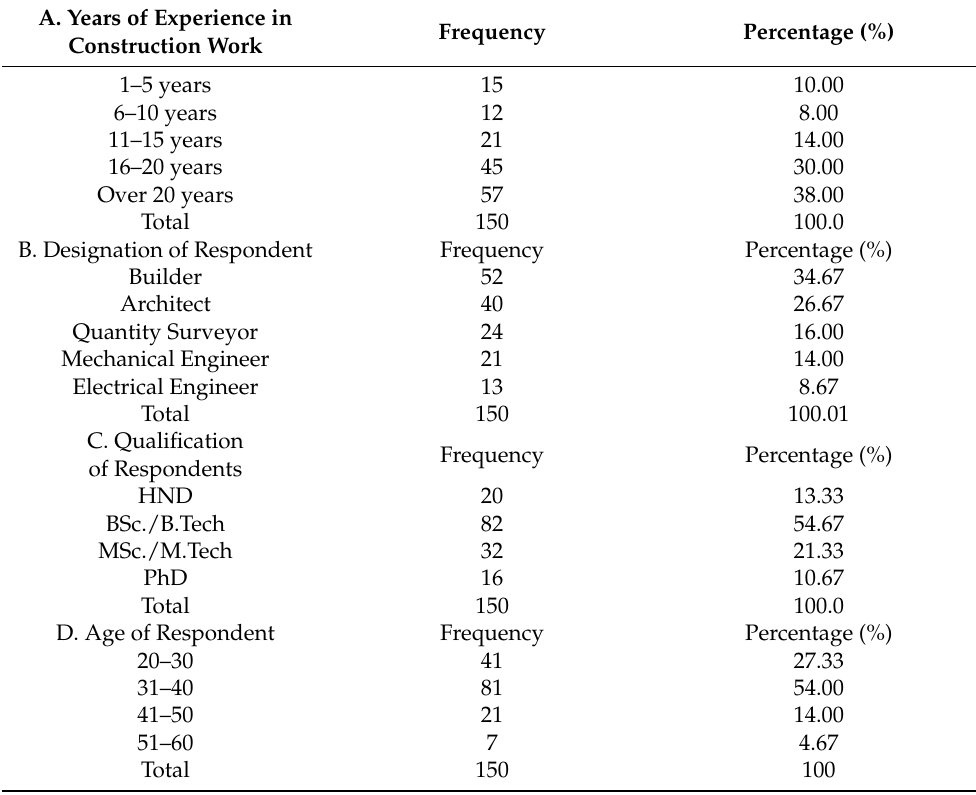
Table 1. Respondents’ biodata